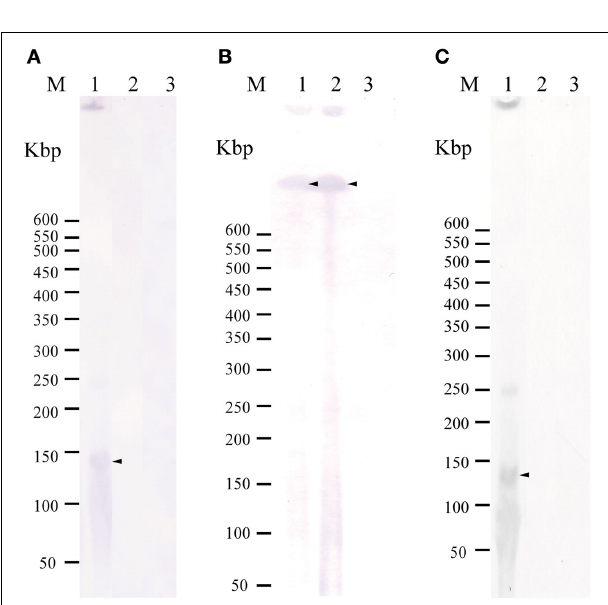
FIGURE 1 | Detection of plasmid(s) in the donors and transconjugants using Southern hybridization following to pulsed field gel electrophoresis with the tet (M) probe (A), traI -pAQU1 probe (B), and rep -pAQU1 probe (C). Lane: M, DNA size standard (lambda ladder); 1,